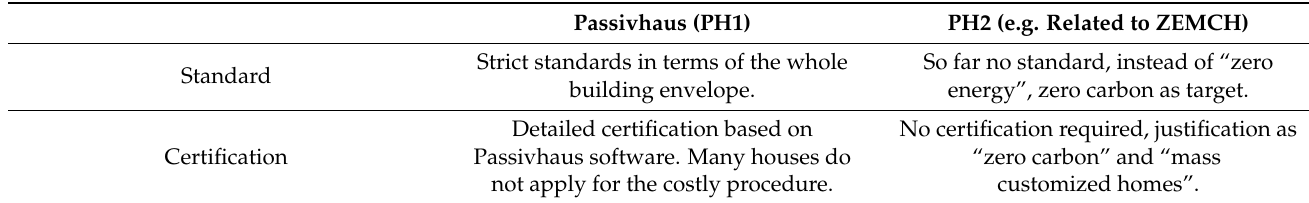
Table 3. Passive Homes—Content Analysis with a Synergetic Comparison of PH1 and